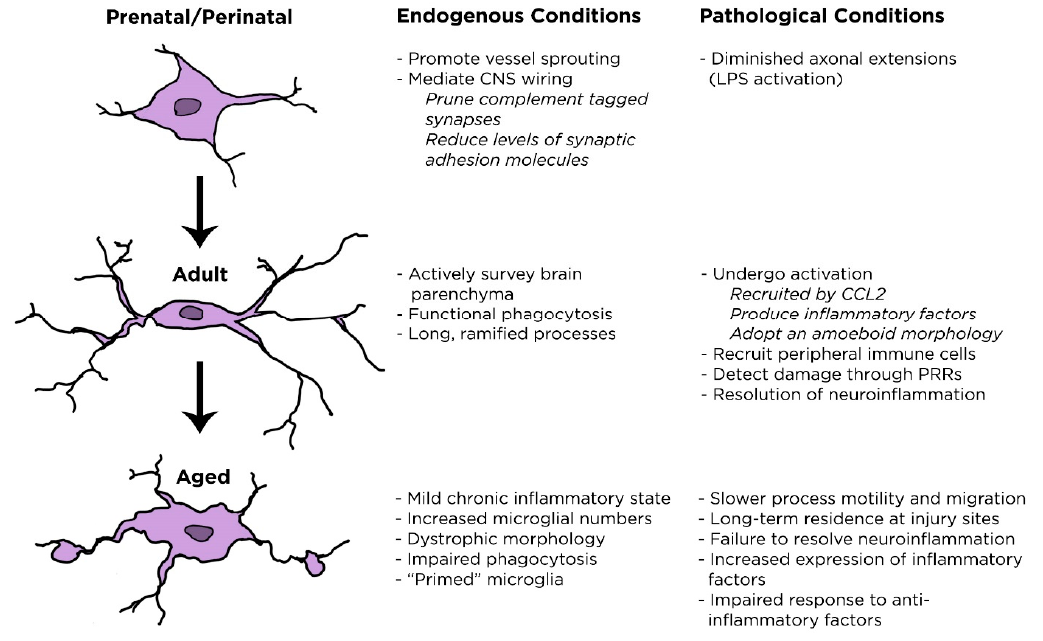
Figure 1. Age-related changes in morphology and function of microglial cells. CNS, central nervous system; LPS, lipopolysaccharide.